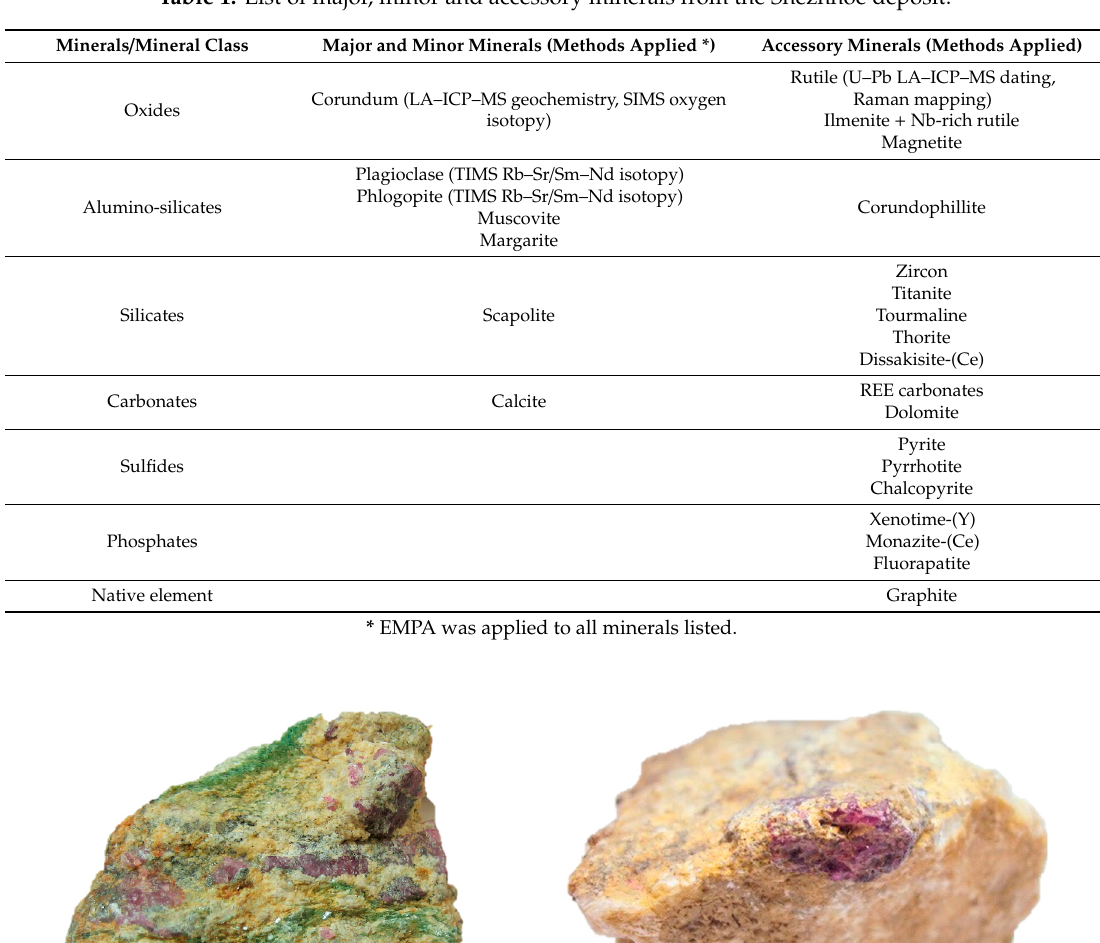
Table 1. List of major, minor and accessory minerals from the Snezhnoe deposit.